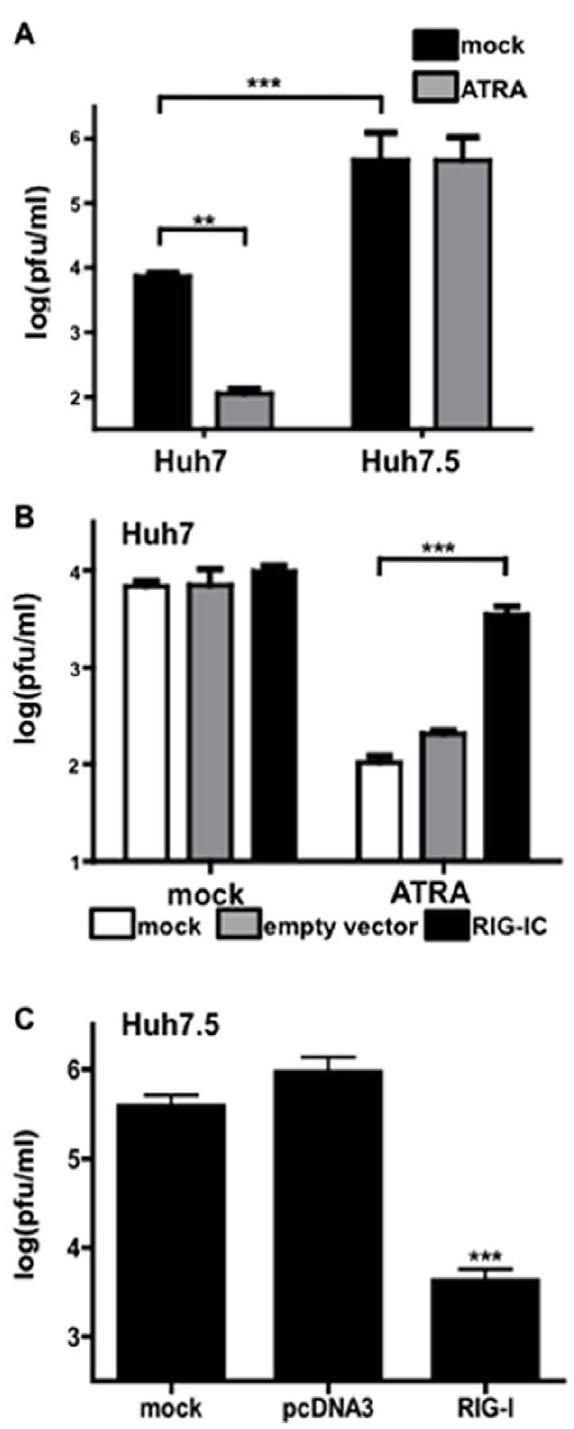
Figure 2. RIG-I necessary for inhibition of MeV by ATRA. (A) Huh7 and Huh7.5 cells were infected MeV at an MOI of 0.01 and treated with 1 m M ATRA or DMSO. Whole cell lysates were harvested after 48 hours and viral titers were measured by plaque assay. (B) Huh7 cells were infected with MeV at an MOI of 0.01 and treated with 1 m M ATRA or DMSO and transfected with the control plasmid or RIG-I dominant negative (RIG-IC) expression construct. Whole cell lysates were harvested after 48 hours and viral titers were measured by plaque assay. (C) Huh7.5 cells were transfected with the control plasmid or RIG- I expression construct and infected with MeV at an MOI of 0.01.